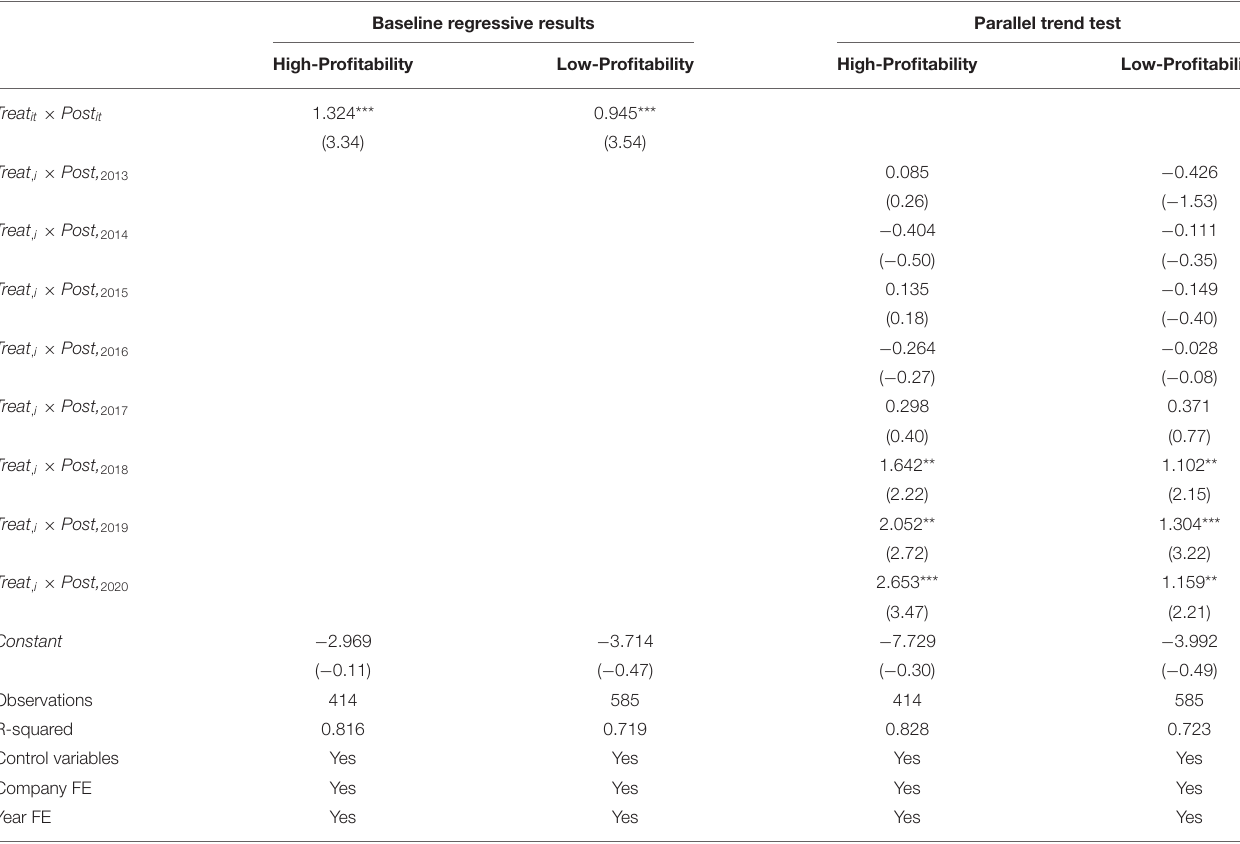
TABLE 8 | Results of profitability heterogeneity